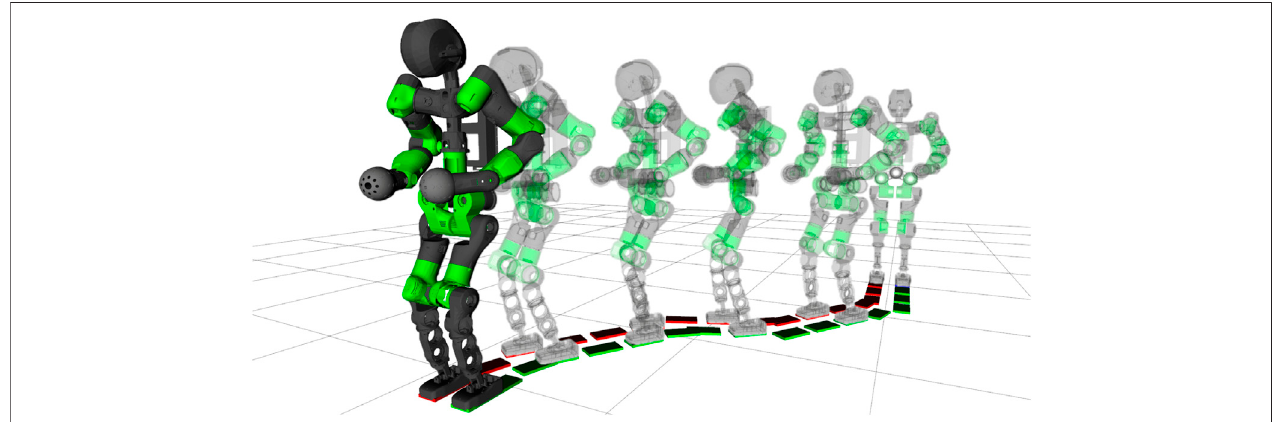
FIGURE 7 | Sequence of frames of the COMAN + performing four steering step, curving two times left of 30 ° and two times right, steering back in the straight direction.